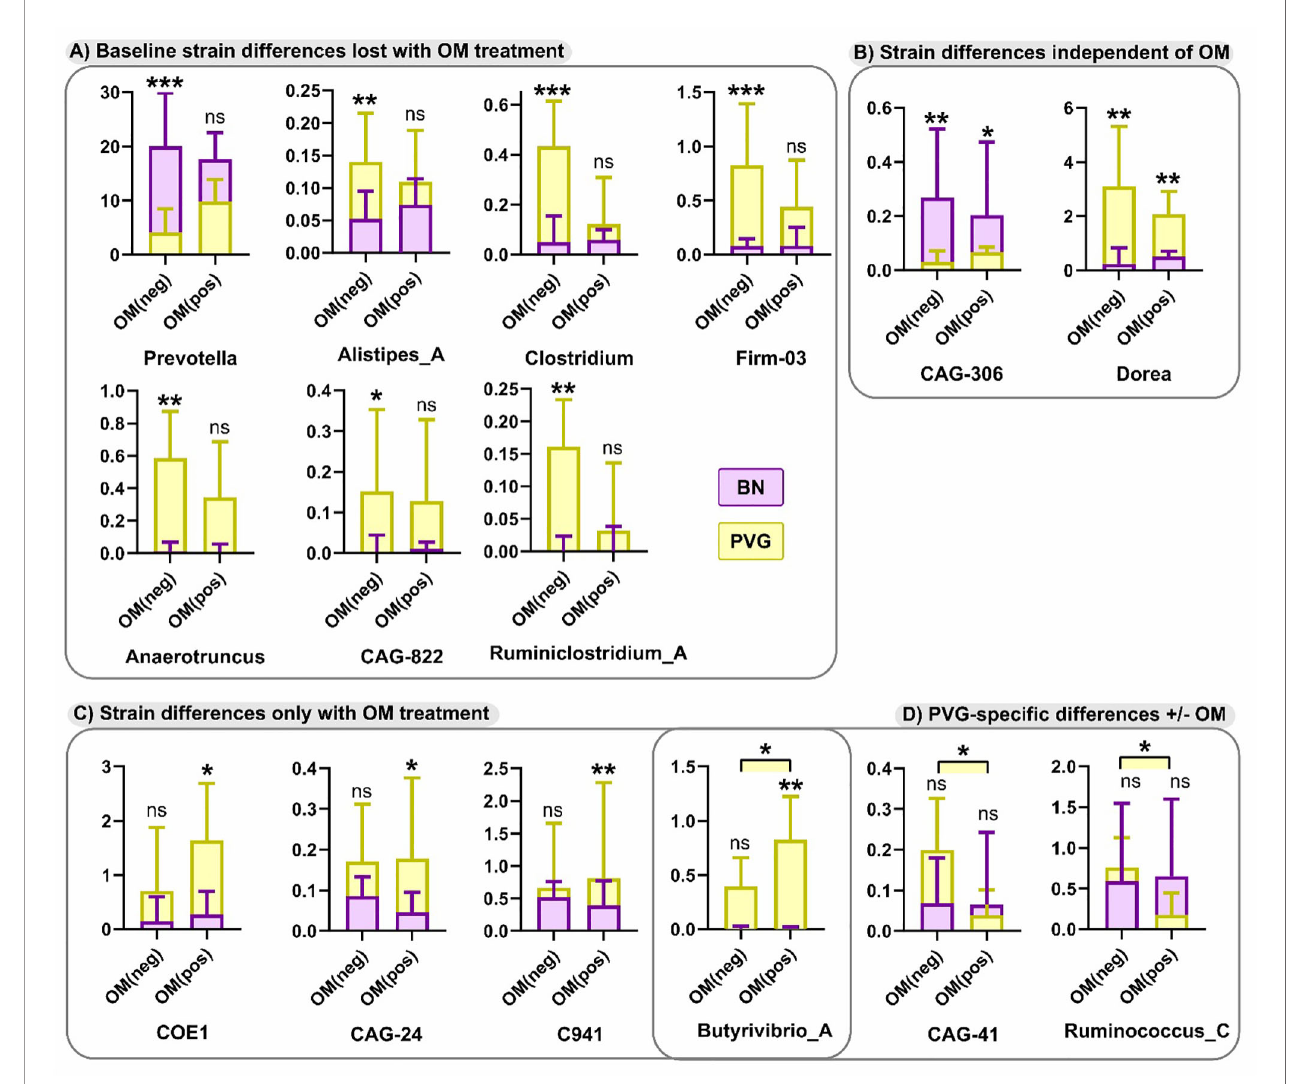
FIGURE 8 | Differences in the microbiome between PVG and BN rats at with and without OM-85 treatment. The effect of OM-85-pretreatment on the microbiome at genus-level. Observed differences were either; evident at baseline (Day 0) without treatment, but no longer different between strains with OM-85 treatment (A) , evident between strains independent of OM-85 treatment (B) , only evident between BN and PVG rats with OM-85 treatment (C) , or evident within PVG rats when comparing treatment groups (D) . Results are presented as relative abundance; bars show median and upper quartile from more than 3 independent experiments with n = 12 per group. NS, not signi fi cant; *p < 0.05, **p < 0.01 and ***p <